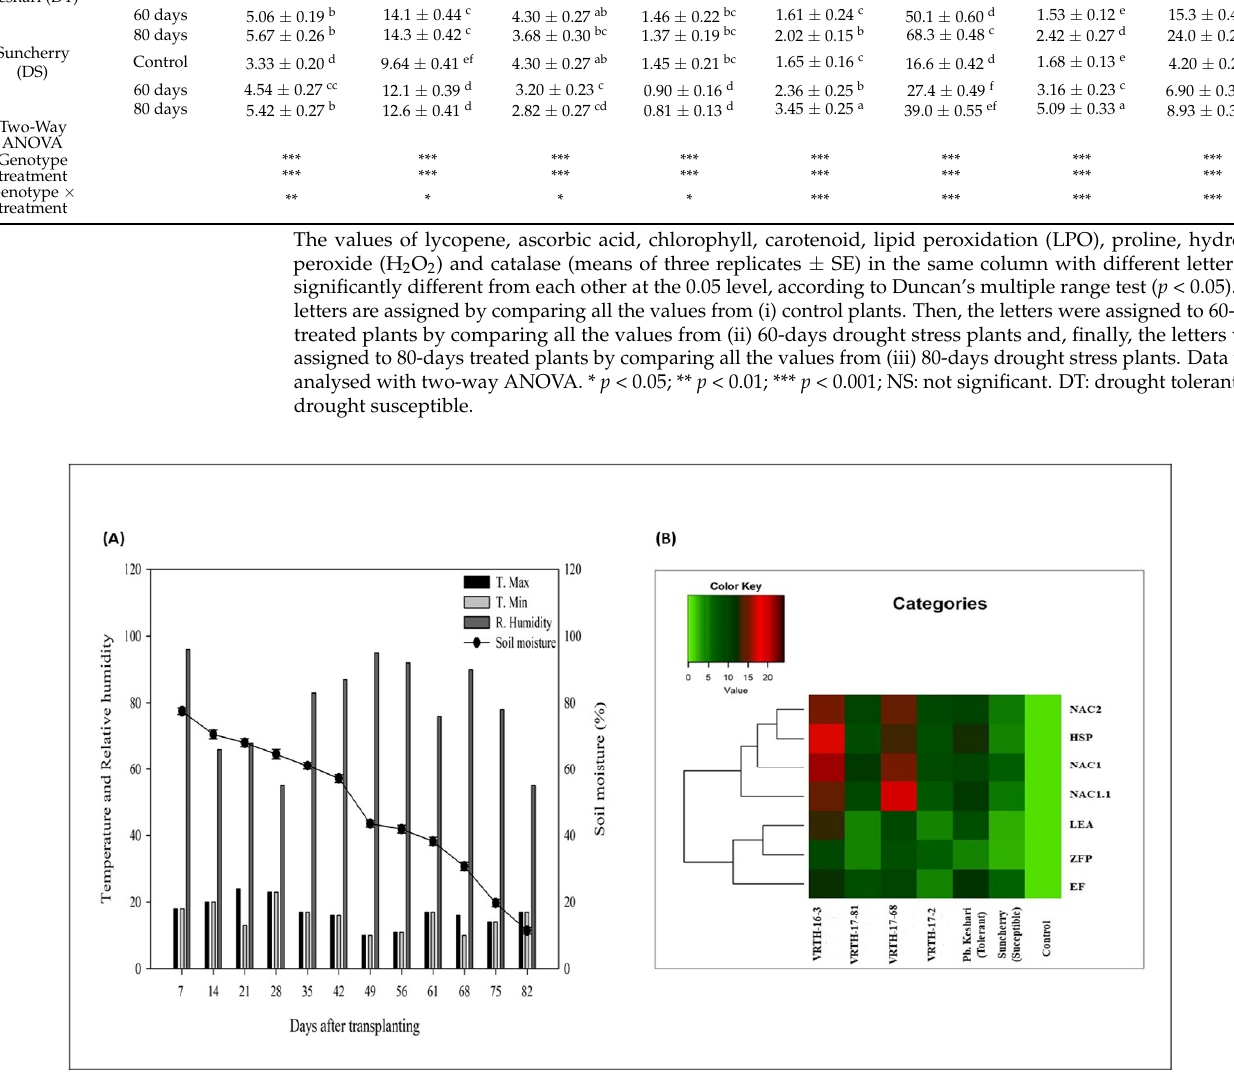
Figure 7. ( A ) Relative humidity (RH) (%), maximum temperature (T. max; °C), minimum temperature (T. min; °C) and soil moisture of experimental site during the investigation. ( B ) Relative expression of stress-responsive genes indicated in the form of heat map. Colour corresponds to the expression level of transcripts with low, intermediate and high expression. Table 4. Changes in nutritional and antioxidant capacity in tomato hybrids/parents under drought stress.